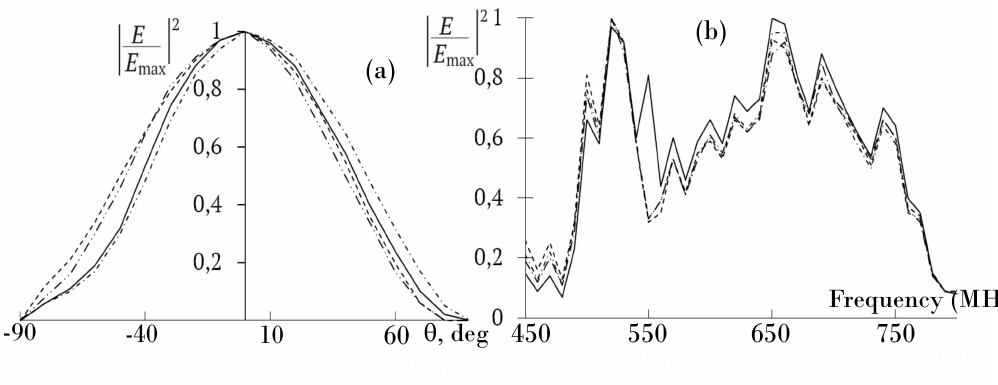
Figure 4. Dipole antenna operating at 600 MHz. ( a ) Radiation pattern and ( b ) Square of the normalized field amplitude of the emitted signal as a function of frequency for four different prototypes with (i) metal radiating elements (solid line), (ii) a longitudinal laying of the carbon fiber on the duralumin base (dashed line), (iii) a curricular winding of the fiber on the fluoroplastic insert (short dashed-dotted line), and (iv) a curricular winding of the fiber on the duralumin insert (long dashed-dotted line). E max is the maximum value of the field